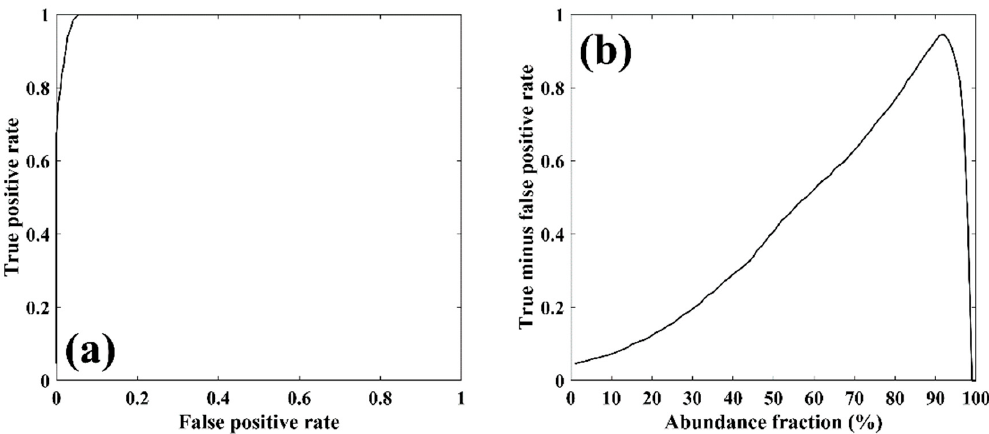
Figure 9. Comparison of ( a ) receiver operating characteristic (ROC) curve according to the abundance fractions of vessels and ( b ) the difference of true minus false positive rate according the abundance fraction.